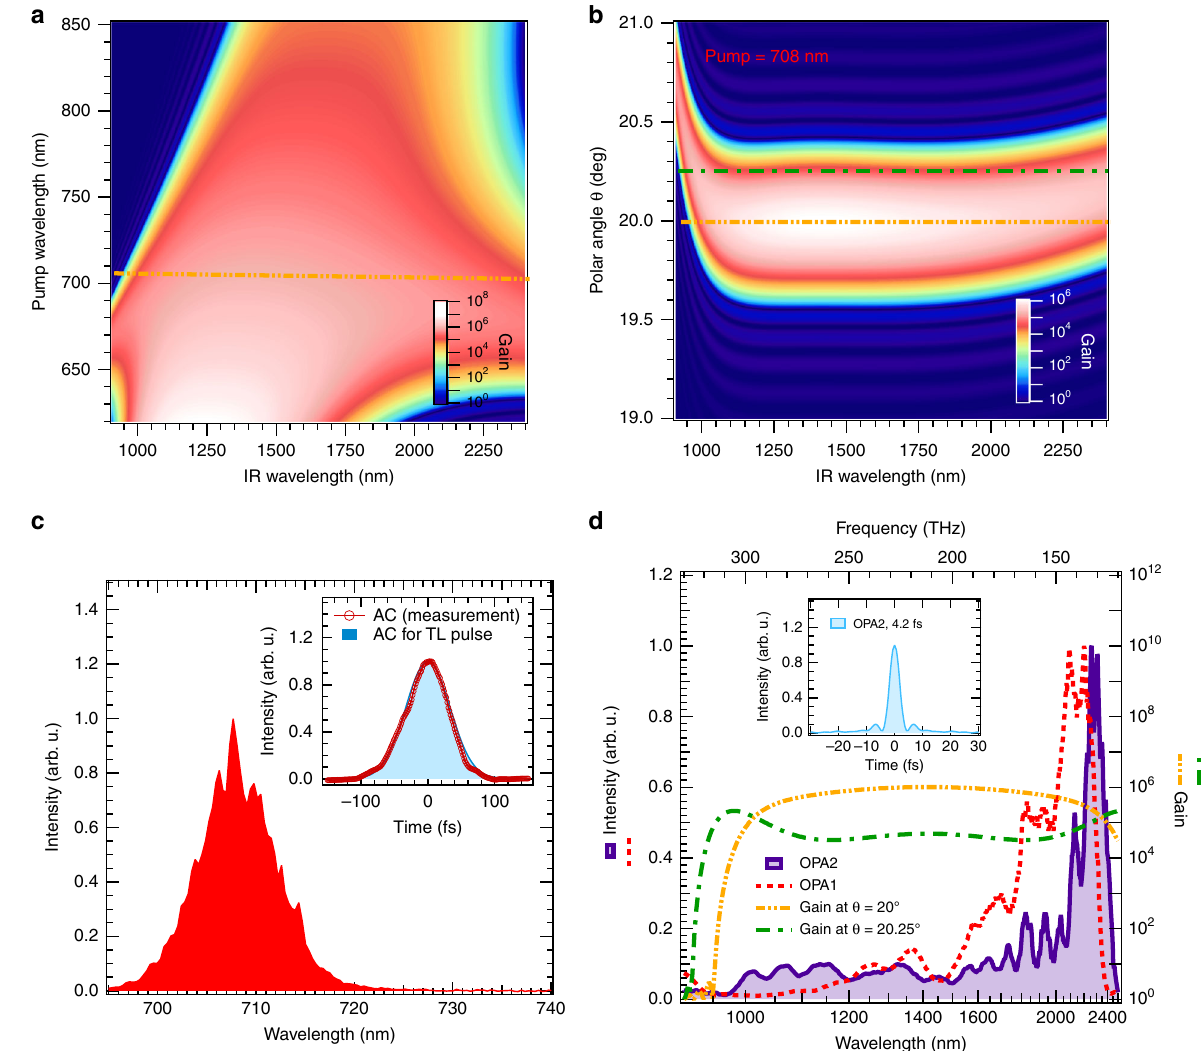
Fig. 2 Spectra for the calculated gain of a BBO, pump beam pulse, and output SWIR pulse. a Calculated gain spectrum of a 3-mm BBO under the type-I phase-matching condition. The phase-matching angle is adjusted for each wavelength of the pump beam so as to satisfy the degeneracy condition for the signal and idler beams in this calculation. The two-dot chain line indicates the pump wavelength of 708 nm. b Calculated gain spectrum at the pump wavelength of 708 nm. Deviation from the complete phase-matching angle θ = 20° was scanned to show the change of the pro fi le of the gain spectrum. The two-dot chain curve and the one dot chain curve specify the angle of 20° and 20.25°, respectively. c Measured spectrum of the output pulse from the Ti:sapphire CPA system. The autocorrelation (AC) trace measured with a single-shot autocorrelator is shown as circles in the inset. The autocorrelation trace of the transform-limit (TL) pulse calculated from the measured spectrum is also shown as the shaded area in the same inset. d Spectra of the output pulses from OPA1 and OPA2 depicted as dashed curve and shaded area, respectively. The calculated gain pro fi le at θ = 20° and θ = 20.25° with the pumping wavelength of 708 nm are depicted with a two-dot chain, and a one-dot chain curves, respectively. The temporal pro fi le of the TL pulse calculated from the output spectrum of OPA2 is shown in the